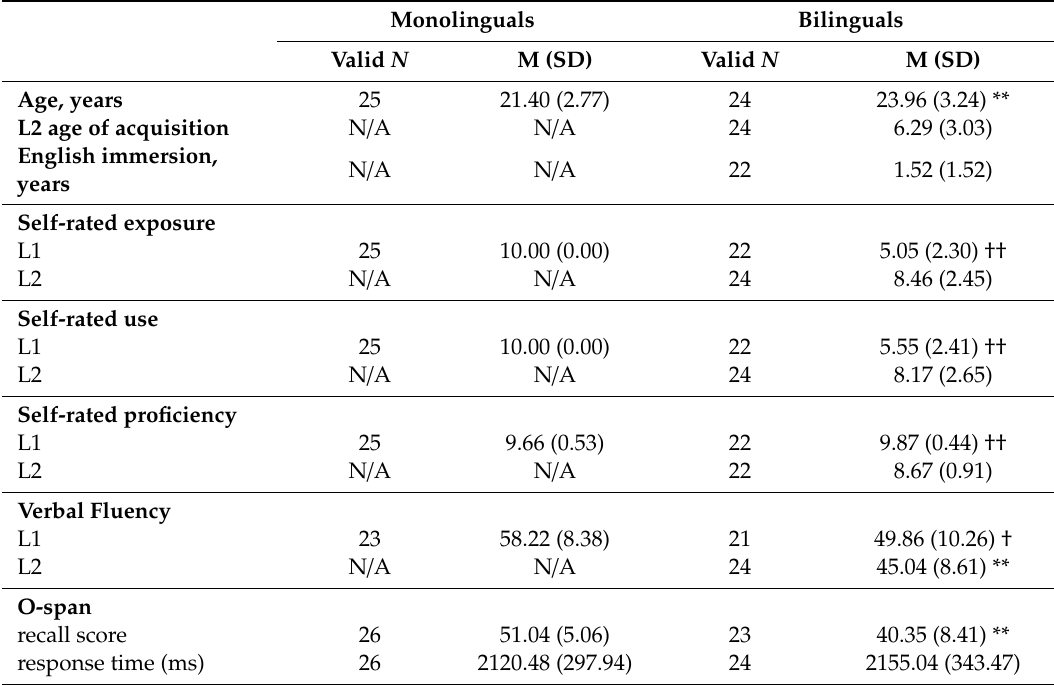
Table 1. Participant